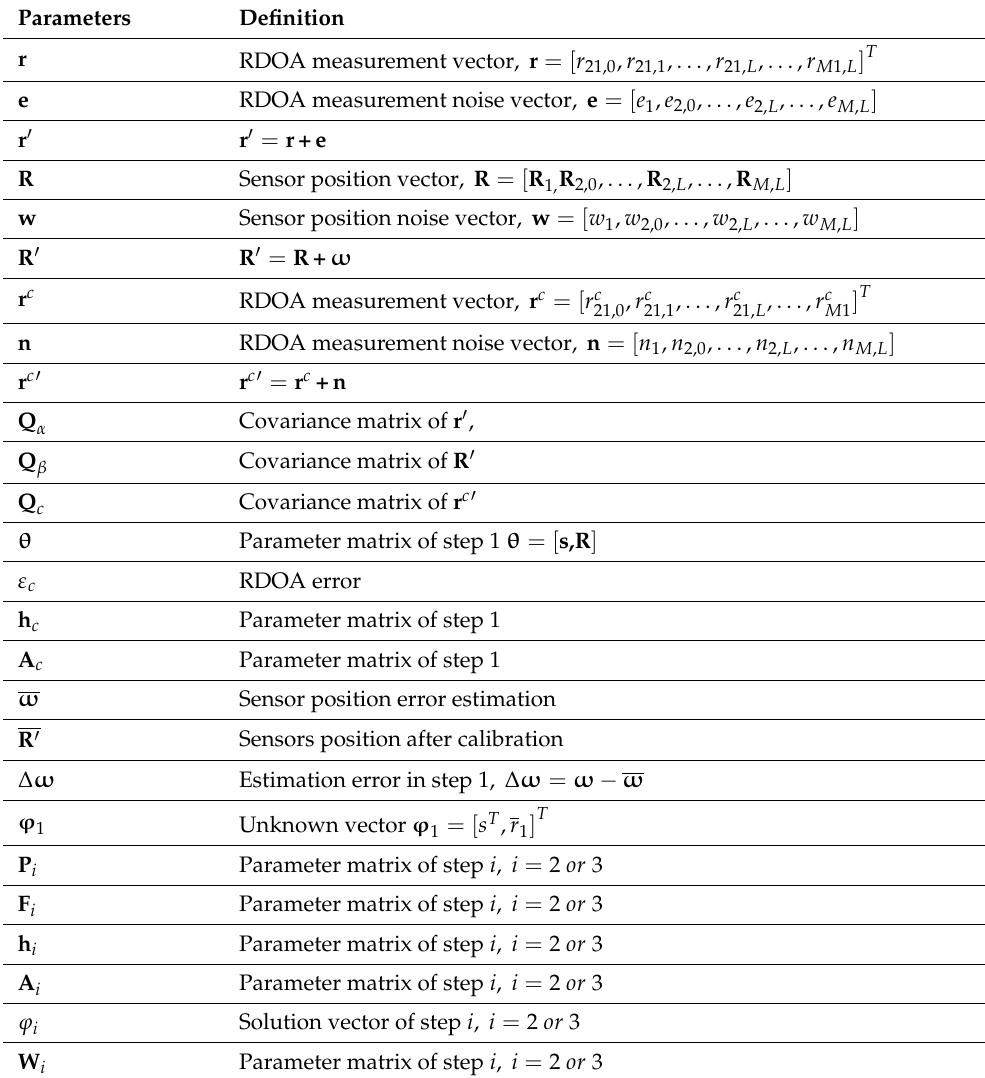
Table A1. Cont. Parameters